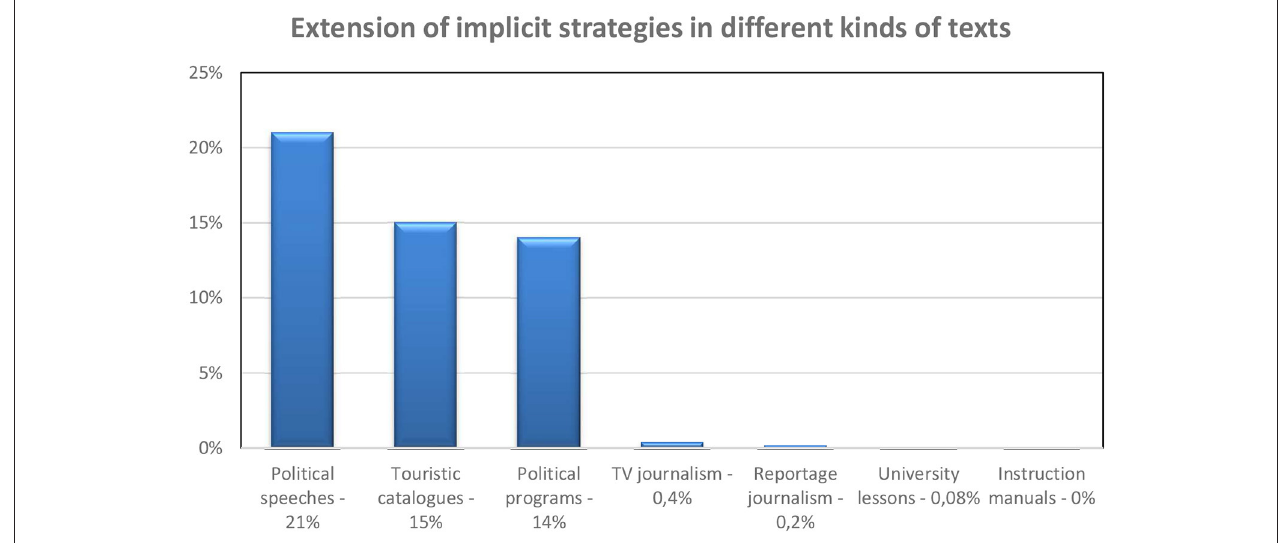
FIGURE 1 | Extension of implicit strategies for questionable contents in a corpus (data from Lombardi Vallauri and Masia,